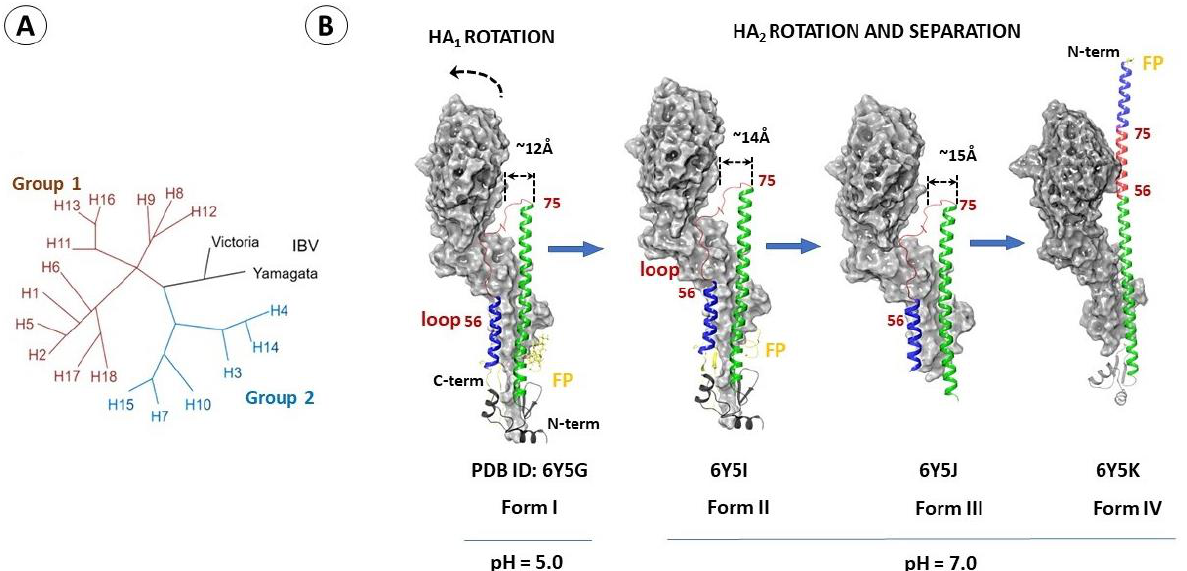
Figure 3. Hemagglutinin of the influenza virus. The phylogenetic tree ( A ). Conformational rearrangements of HA ( B ) the HA 1 subunit is shown in gray; the short α -helix (a. a. 38 – 55) is highlighted in blue; the loop (a. a. 56 –75) is red; the long α -helix (a. a. 76 – 126) is green; FP — fusion peptide is shown in yellow; the distances between the amino acids D 1 104 and R 2 76 are shown in Å.